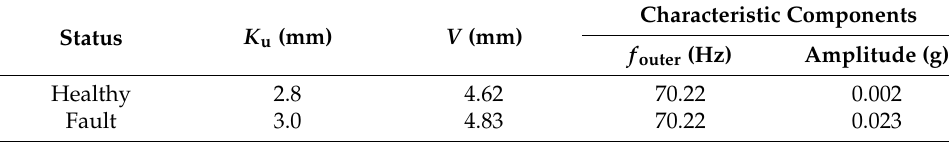
Table 8. Bearing outer race fault diagnosis results of the Y132M-4 motor with a full load. Status